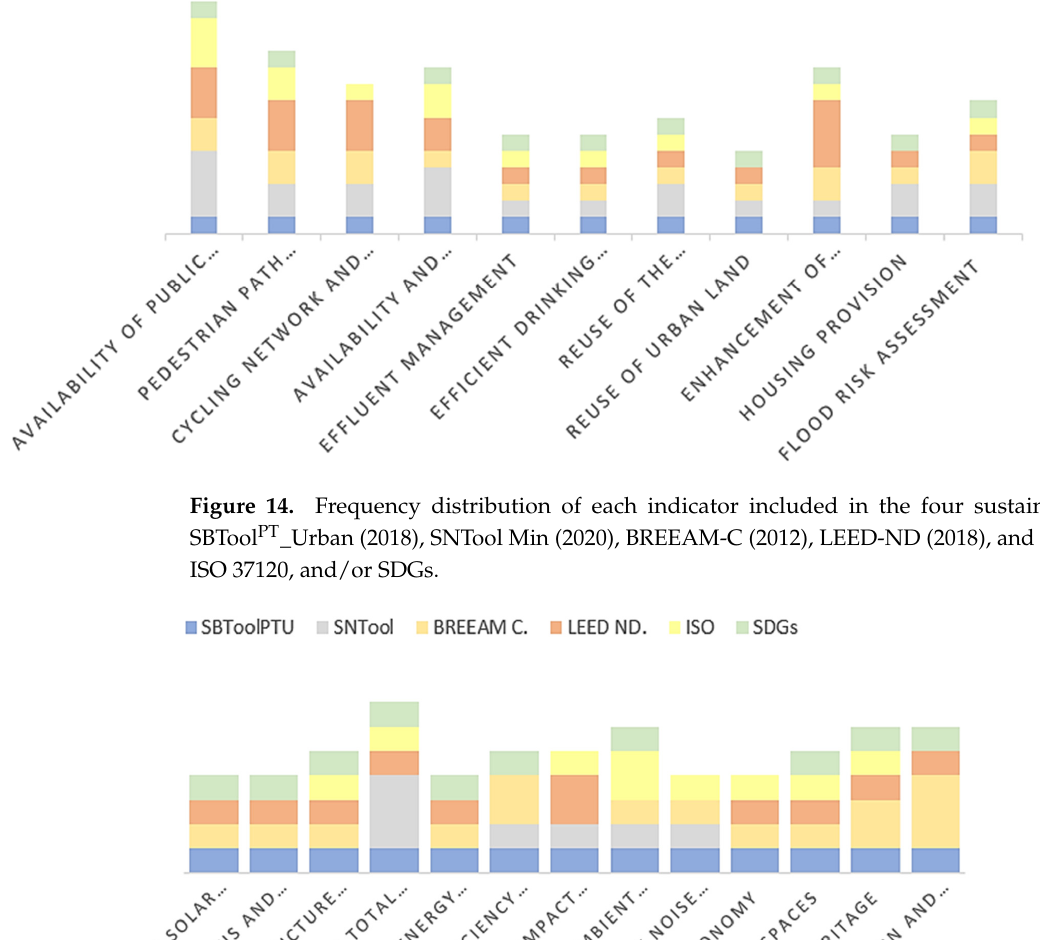
Figure 13. Frequency distribution of each indicator, in SBTool PT _Urban (2018), SNTool Min (2020), BREEAM-C (2012), LEED-ND (2018), ISO 37120, and SDGs.